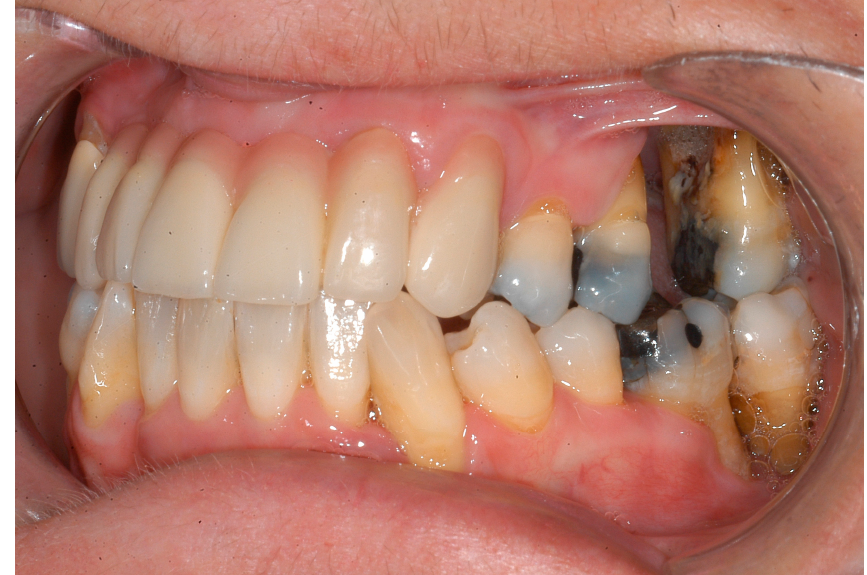
Figure 1. Excessive periodontal destruction in a 48-year-old women with Langerhans cell histiocytosis.